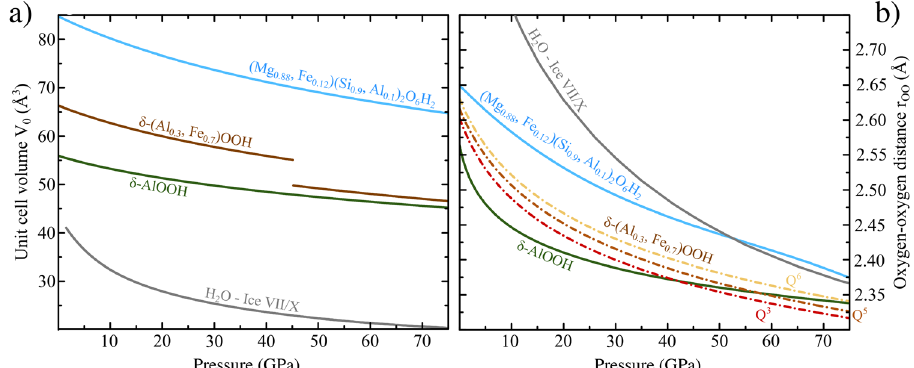
Fig. 2 Structural data of investigated systems. a Equation of state (EOS) data of the different hydrogen-bonded phases. We use the EOS for H 2 O ice-VII/ X (gray graphs) of from 22 , based on ab-initio computations and the XRD based EOS of 21 for δ -AlOOH (green graphs). The other curves are based on third order Birch-Murnagham EOS fi ts to our diffraction data for iron-bearing δ -AlOOH (brown graphs) and phase-D (blue graphs). δ -(Al 0.3 ,Fe 0.7 )OOH exhibits a 7% volume collapse associated to the electron spin crossover of ferric iron (c.f. Fig. 4a). b Oxygen-oxygen distance ( r OO ) as a function of P . Different pressure dependencies of the Q i (i = 3, 5, 6) (red, brown and yellow graphs respectively) H-bond environments in δ -(Al,Fe)OOH 20 were estimated through interpolation of r OO between endmembers δ -AlOOH 10,21 and ϵ -FeOOH 25 with respect to the local iron content. We only consider the high spin state in iron bearing phases, as the spin transition occurs at signi fi cantly higher P ( ~45 GPa) than the hydrogen-bond symmetrization (~15 GPa).